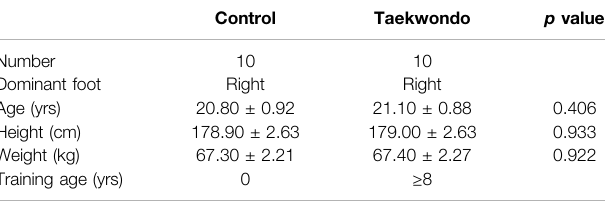
TABLE 1 | Basic characteristics of